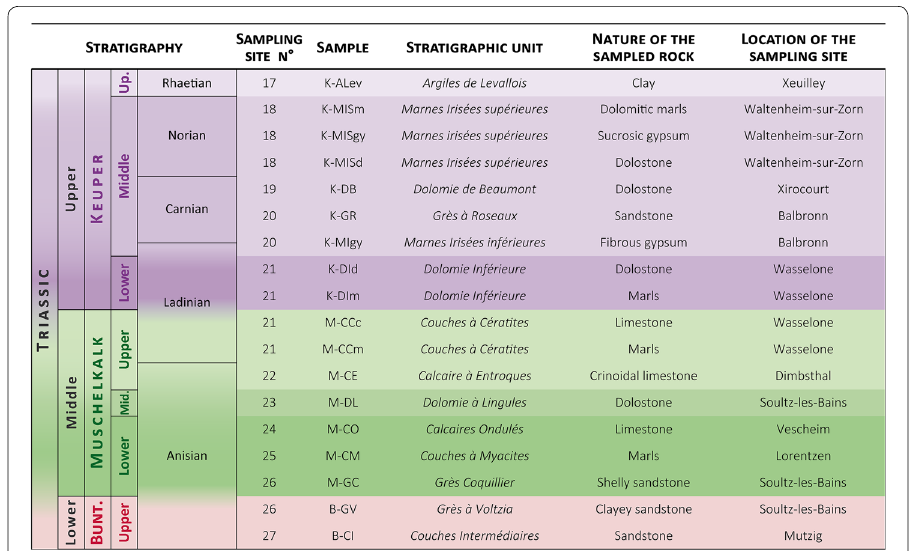
Fig. 3 List of Keuper , Muschelkalk and Buntsandstein samples classed in stratigraphic order. Lithostratigraphic unit, number of the sampling site (see Fig. 1 for location on the map), nature of the sampled rock and location of the sampling site are